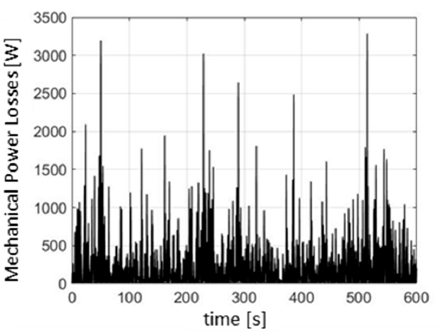
offline estimation of temperature dynamics in the PTO module. Since heat production